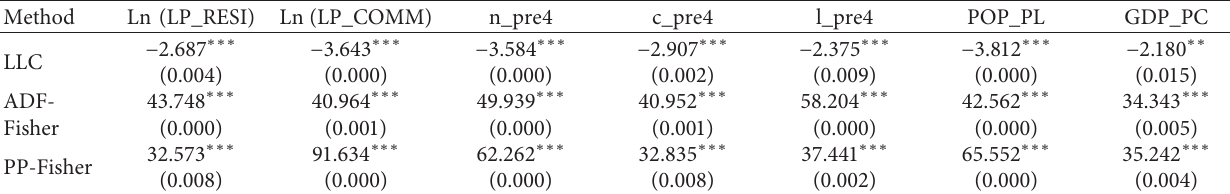
Table 4: The results of unit root test for panel